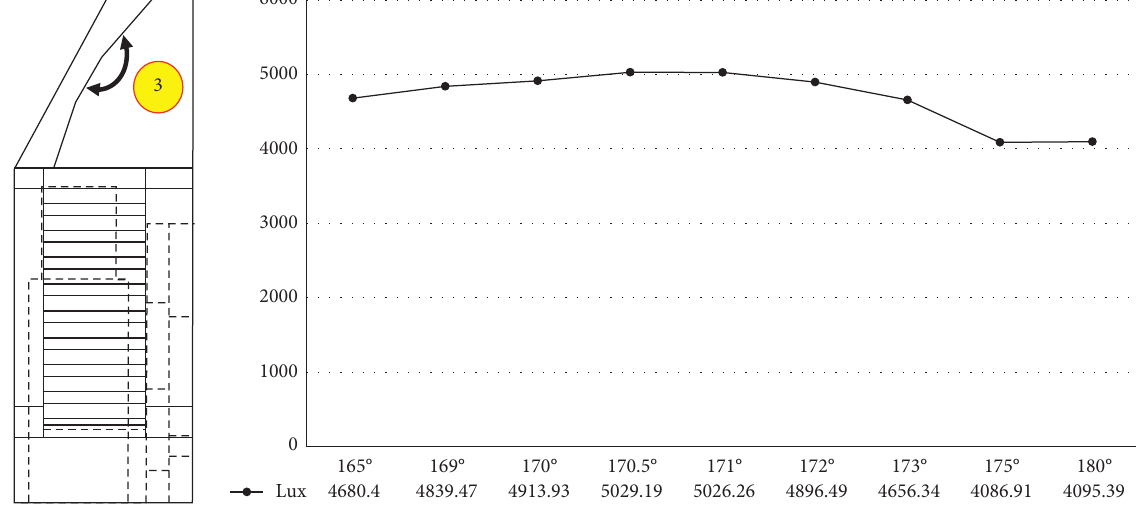
Figure 10: Schematic diagram of geometric bevel angle 3 and optical simulation results.